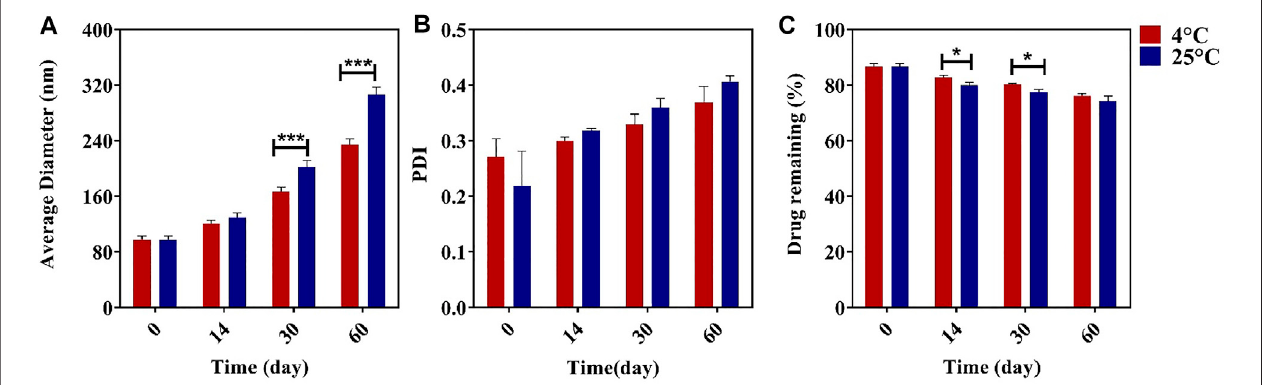
FIGURE3| Effectofdifferenttemperaturesofstorageontheaveragediameter (A) ,polydispersityindex(PDI) (B) ,andstreptomycinsulfateencapsulationef fi ciency (EE%) (C) n (cid:1) 3, * p value < 0.05, ** p value < 0.01, and *** p value < 0.001.